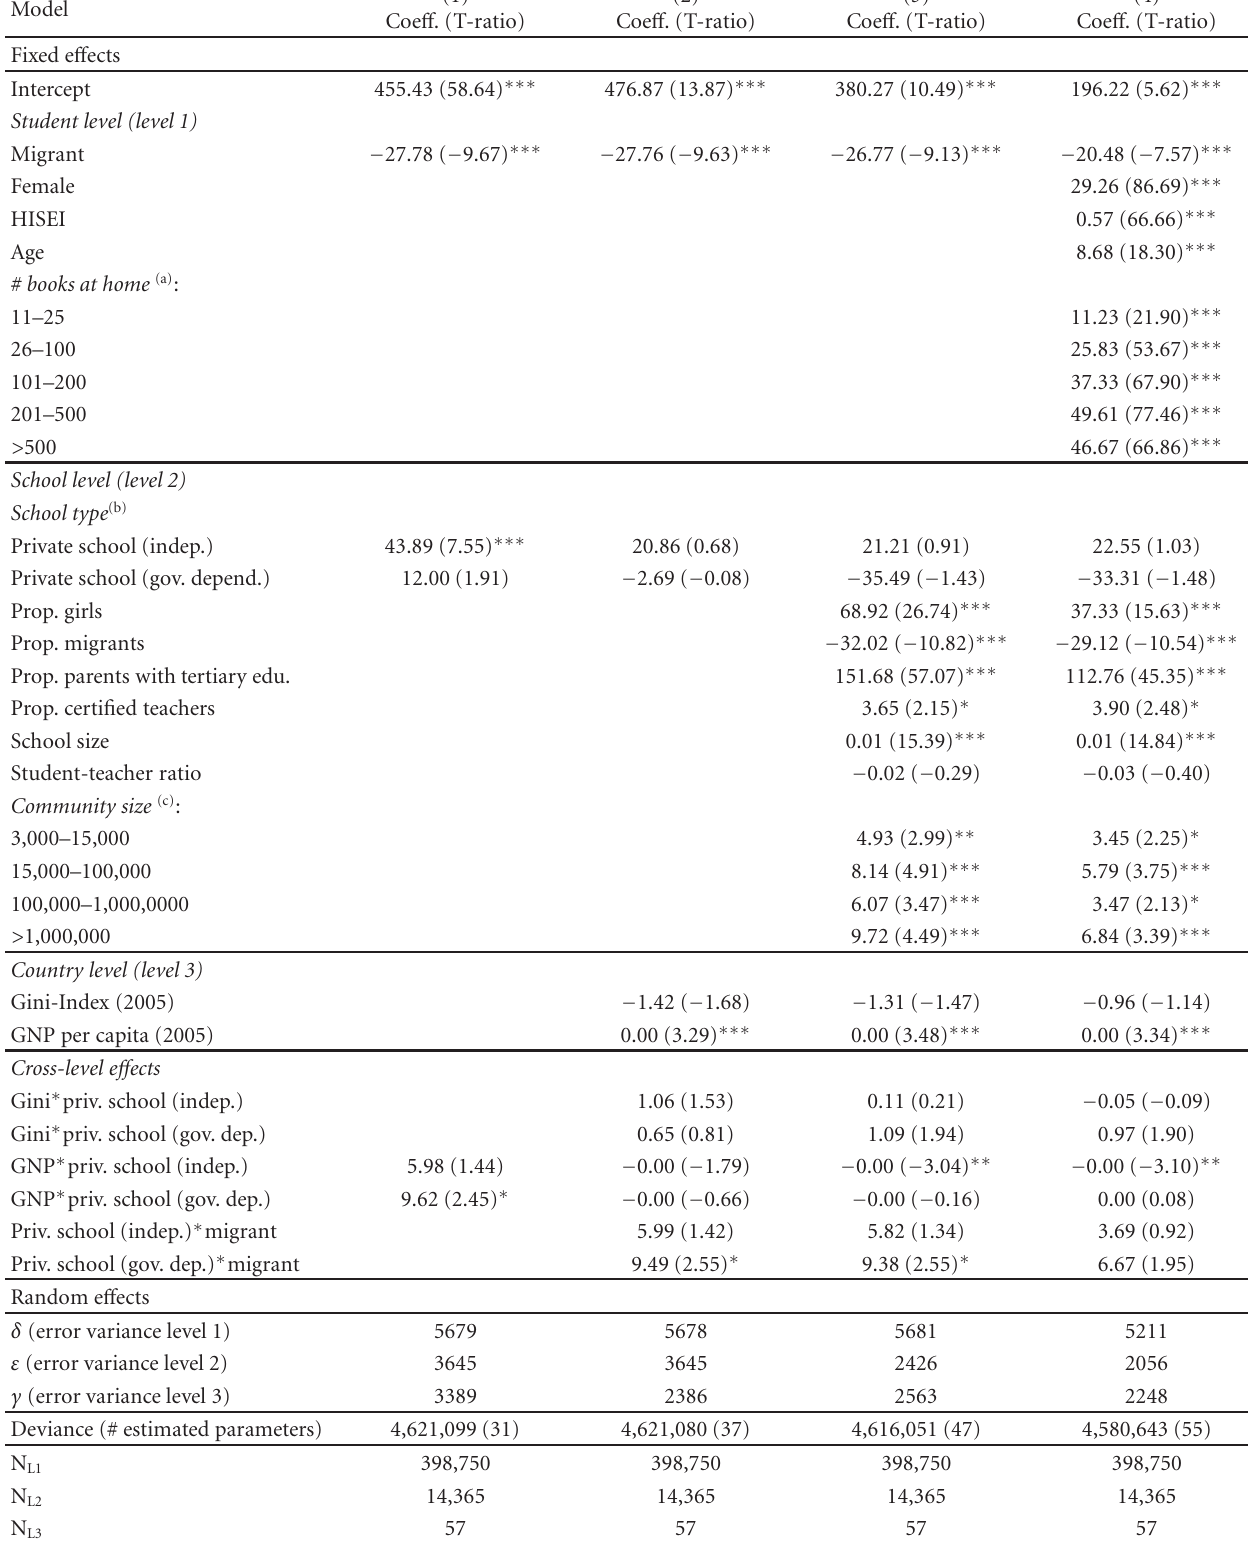
Table 7: Hierarchical multilevel models: determinants of reading